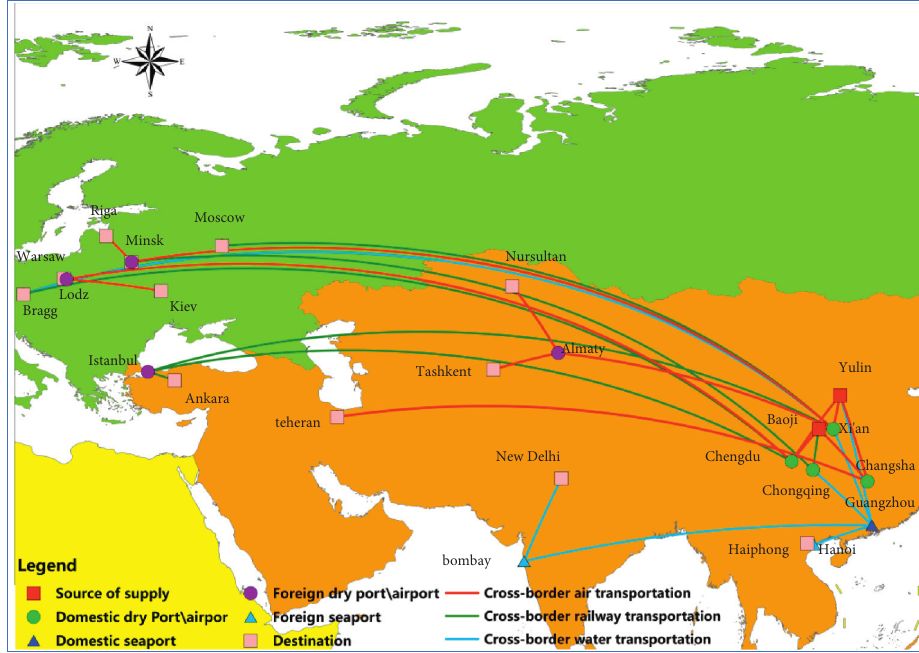
Figure 7: The optimal cross-border logistics paths in northwest region.